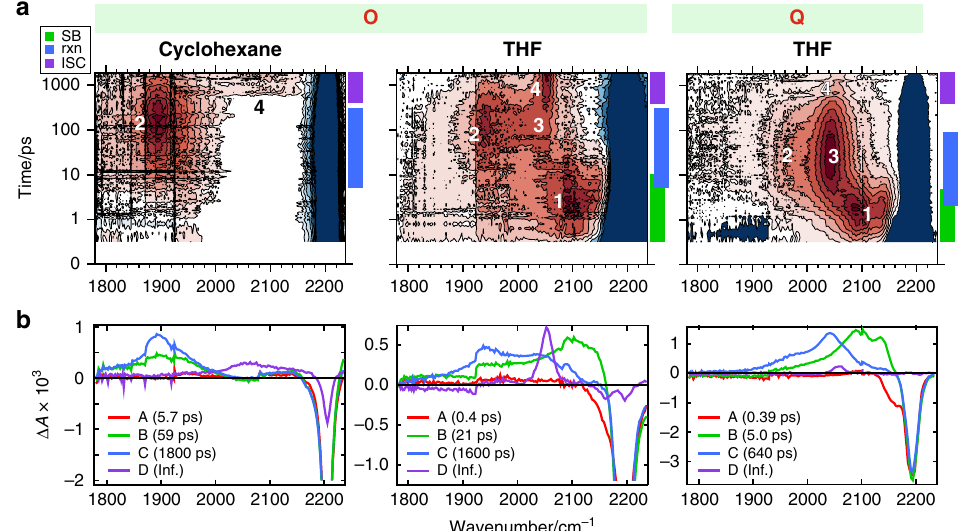
Fig. 4 Double-difference TRIR spectroscopy of the multipolar compounds. a Vibrational double-difference TRIR contour maps of O in the non-polar cyclohexane and of O and Q in the polar tetrahydrofuran (THF). Excited-state absorption bands are in red and marked with numbers (see text), ground- state bleach is in blue. The time axis is linear between 0 and 1 ps and logarithmic afterwards. Color bars indicate the dominant processes taking place over the speci fi ed timespan: symmetry breaking (SB, green), reaction (rxn, blue) or intersystem crossing (ISC, purple). b Evolution-associated double-difference spectra obtained from global analysis of the corresponding data shown in a assuming a consecutive A → B → C → D → reaction